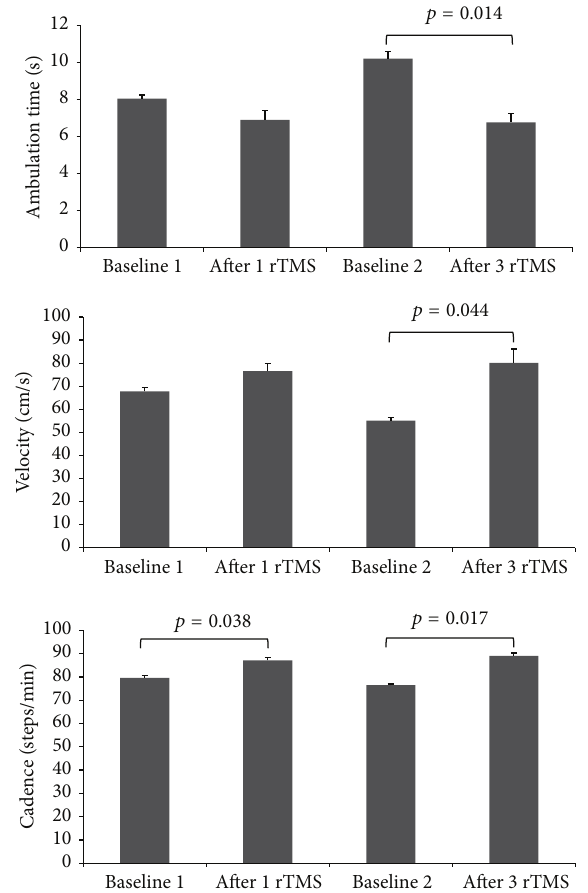
Figure 2: Mean data from three usual gait trials showing ambulation time, velocity, and cadence at baseline, after one rTMS session, at baseline 2 (three days after one rTMS session), and after three consecutive daily rTMS sessions. Ambulation time was significantly shorter and velocity was significantly faster only after 3 rTMS sessions while cadence was significantly higher after both 1 and 3 rTMS sessions (see Table 1 for